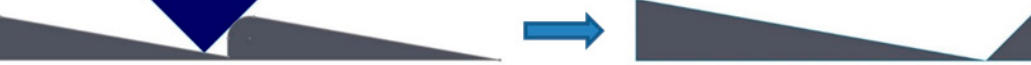
Figure 5. Representation of the roughness tip with the printed layers, for print orientation angle higher than 45°.